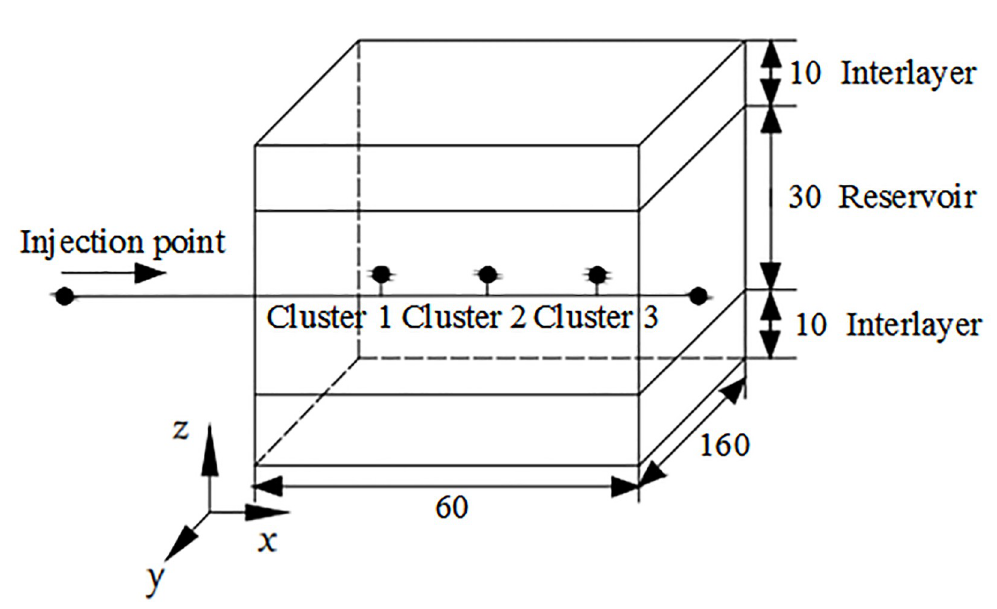
Fig 3. Three-dimensional fracture structure